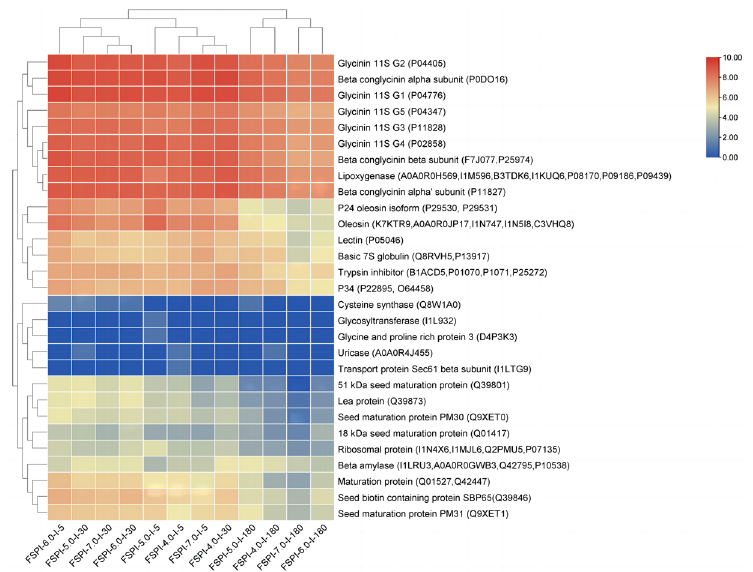
Figure 7. Clustering heat map representation of soy proteins responsible for the release of peptides identified in the FSPI digestates. I-5, I-30, and I-180 represent the gastrointestinal digestates collected from the artificial intestine at 5 min, 30 min, and 180 min, respectively.